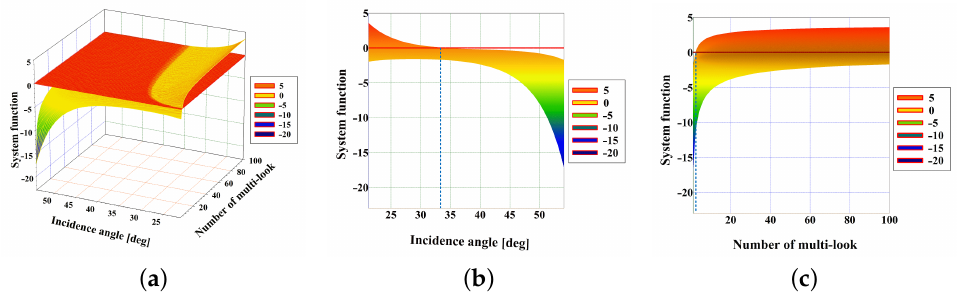
Figure 10. ( a ) The SAR system function varies with the incidence angle φ and the number of multi- looks L look when the average transmitting power, satellite height, and scale factor of water ice are P av = 100,000 W, H sat = 100 km and 10%. ( b , c ) are the simulation results of the system function changing with φ and L look ,